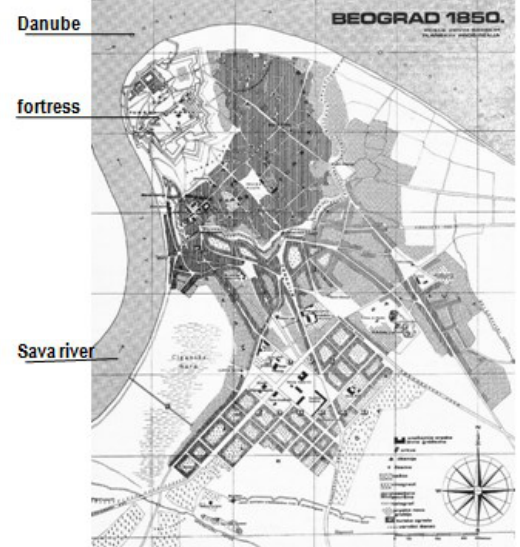
Figure 2. Old Belgrade: the traditional historic city (Plan of Belgrade of